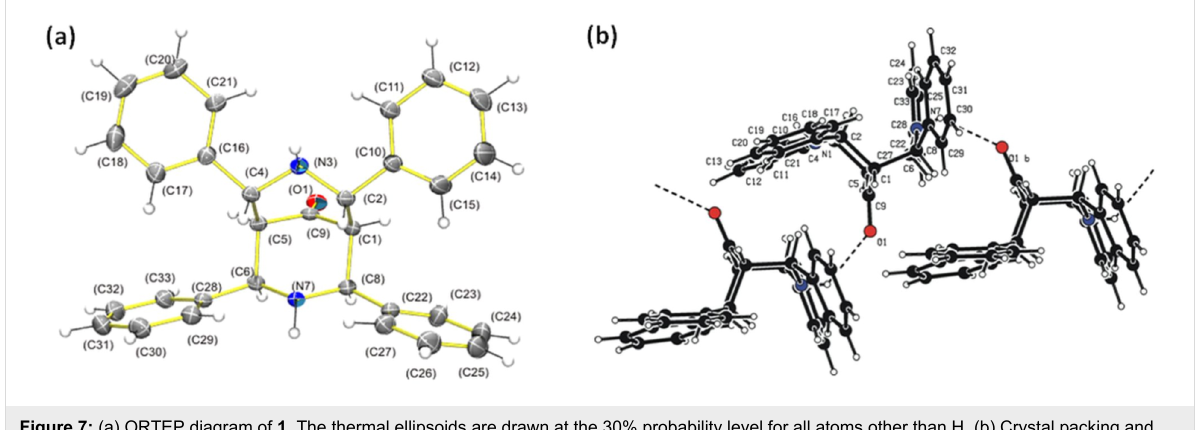
Figure 7: (a) ORTEP diagram of 1 . The thermal ellipsoids are drawn at the 30% probability level for all atoms other than H. (b) Crystal packing and N(3)–H(3) ∙∙∙ O(1) intermolecular hydrogen bonds of 1 .